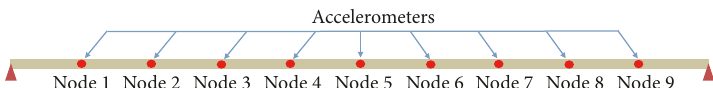
Figure 4: Locations of accelerometers to record acceleration data.